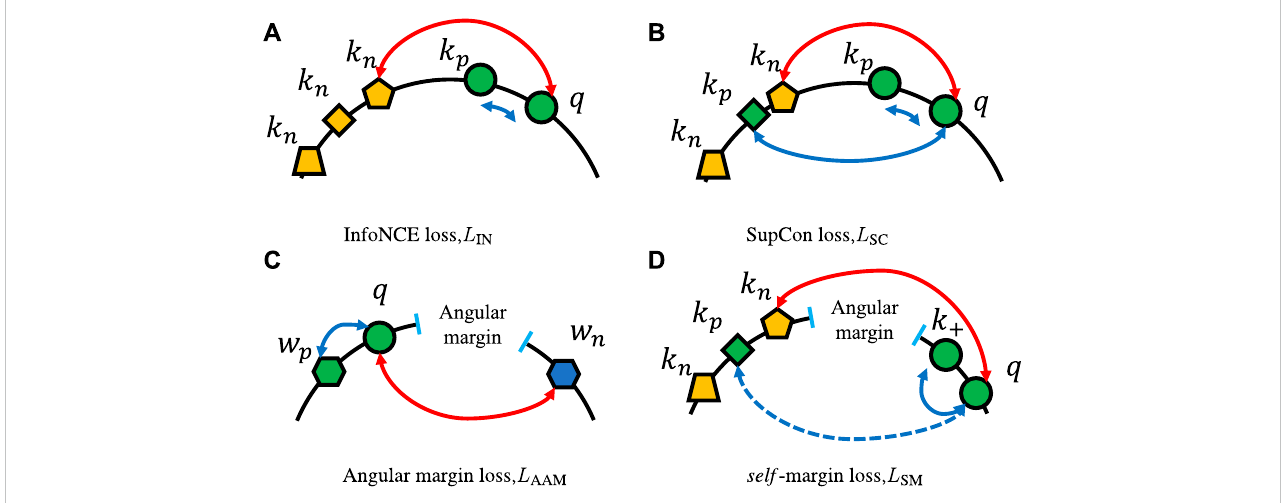
FIGURE 6 Examples of various loss functions. (A) InfoNCE loss, which pulls query q and current key k p together and regards each old embedding in the memory queue as negative key k n , which should be pushedaway. (B) SupConloss, in which not only the current key but old keys that have the same class as the query should be pulled close. The example of angular margin loss in (C) shows how hard margin constrains parametric weights and makes the same class embeddings more compact. (D) Depiction of our self -margin loss, which only enforces the angular margin between the query and the current key and ignores other positive keys in the memory